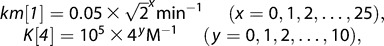
Transient Response of the Wild-Type and Virtual MutantsThe response time, defined as the time at which the level of unfolded proteins recovers to within 90% of its pre-shock value, is plotted versus the total σ32 concentration at low temperature. The level of σ32 parameterizes the 2-D parameter space (the transcription rate constant for σ32 and the association constant between σ32 and DnaK) that satisfies the yield and efficiency constraints (yield > 0.9 and efficiency > 0.85 at low and high temperature). The two parameters:
were varied for the wild-type (SEQ-FB + DEG-FB + FF) (▵): K[5] = K[6] = 1 × 108 M−1, kx[1] = kx[2] = 5 min−1, η = 1 (low), η = 2 (high), for the DEG-FB/FF double mutant (SEQ-FB) (⋄): K[5] = K[6] = 0 M−1, kx[1] = kx[2] = 0 min−1, η = 1, and for FF mutant (SEQ-FB + DEG-FB) (•): K[5] = K[6] = 1 × 108 M−1, kx[1] = kx[2] = 5 min−1, η = 1. For SEQ-FB/DEG-FB double mutant (FF alone) (X): K[4] = K[5] = K[6] = 0 M−1, kx[1] = kx[2] = 0 min−1, η = 1 (low), the two parameters of km[1] and η (high temperature) are varied as:
In the mutant where FF is operating alone in open loop, the parameter combination of km[1] = 0.04 min−1 and η = 1 (low), η = 2 (high) is the only solution to satisfy the required yield and efficiency.